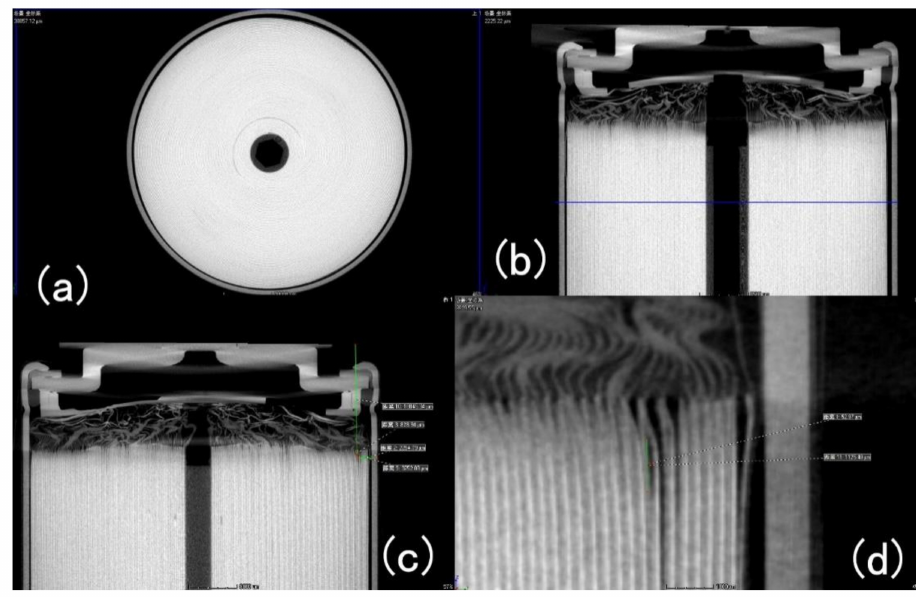
Figure 13. The CT images of cells; ( a , b ) Cell no. 3; ( c , d ) cell no.